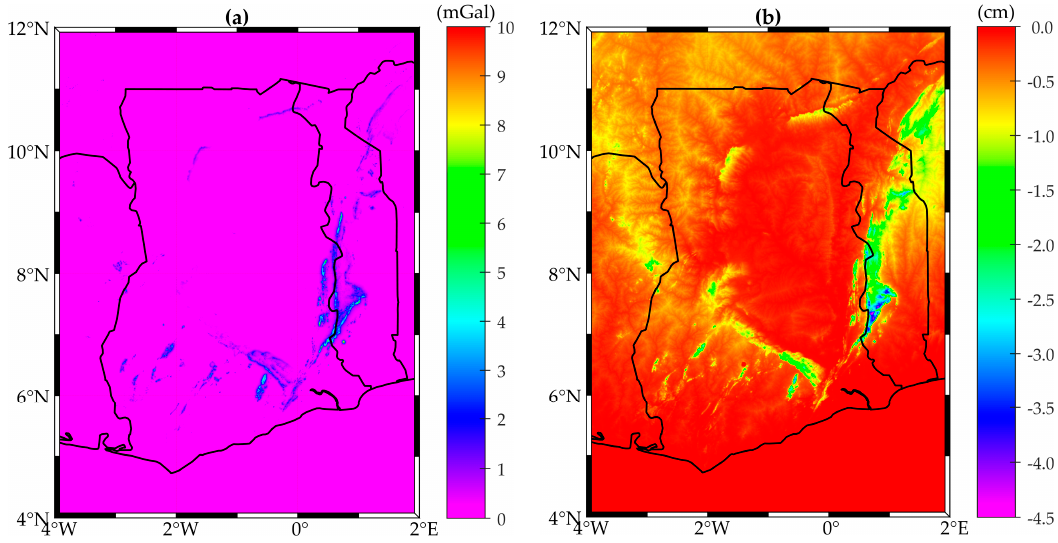
Figure 1. Topography-generated gravity field quantities for the study area computed using SRTM30_PLUS topography/bathymetry; ( a ) Terrain correction computed using SRTM30_PLUS topography/bathymetry data as input for Equation (17); and ( b ) Indirect effect computed using Equation (18).